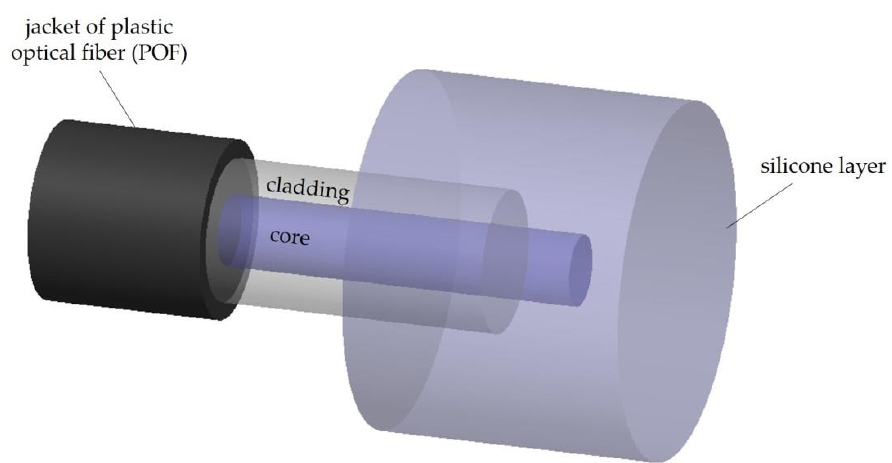
Figure 7. Schematic drawing of the temperature sensor proposed by Cennamo et al. (Adapted from [138].)